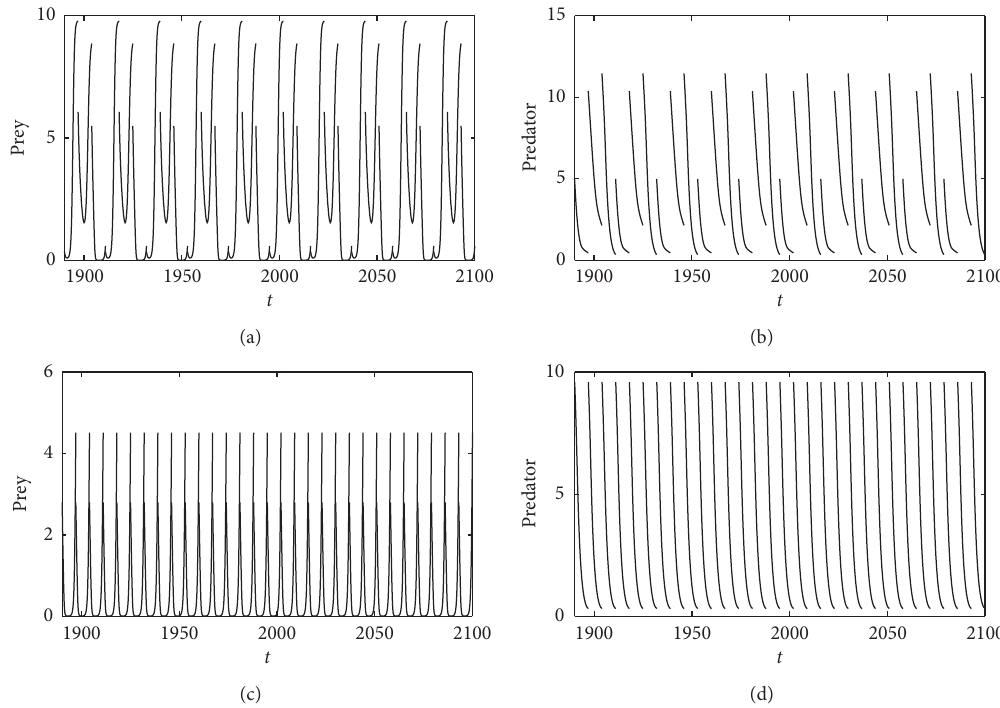
Figure 2: Two coexisting attractors of model (1) with T � 7. The other parameter values are identical to those in Figure 1. The initial conditions are as follows: ( A − B )( x